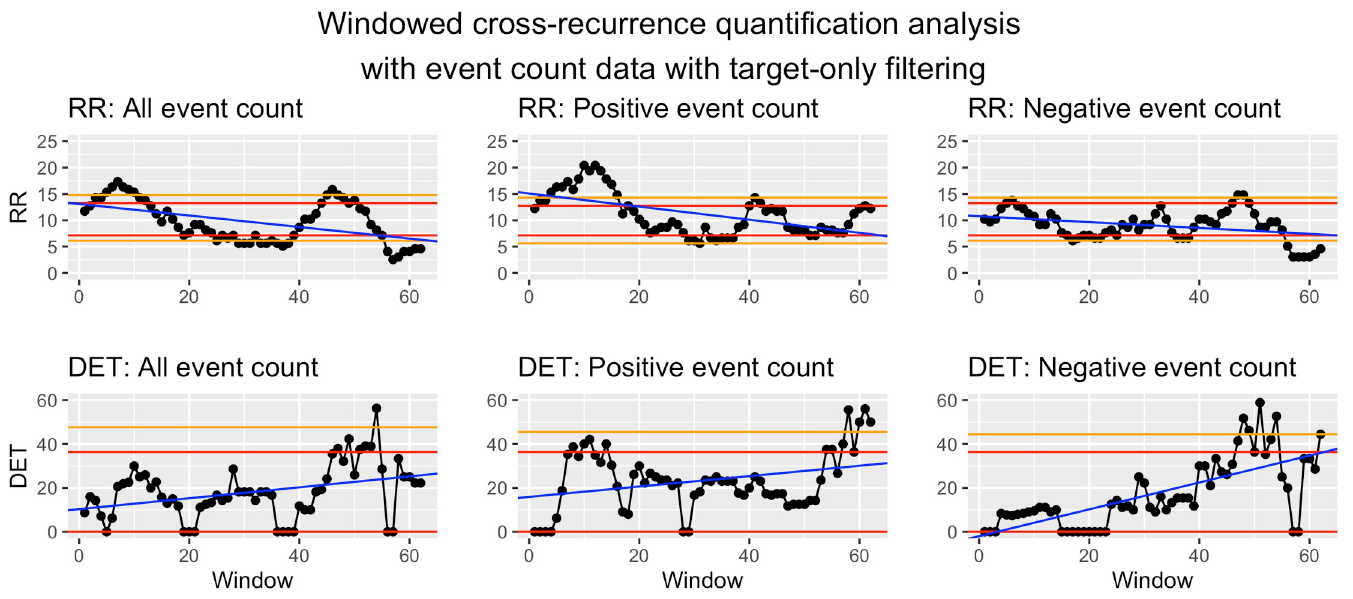
Fig 10. Windowed CRQA for social cohesion and event counts from target filtered data.